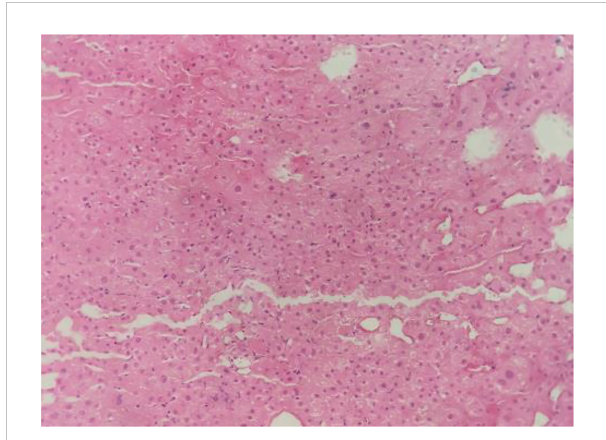
FIGURE 3 Histological fi ndings of the liver at autopsy (hematoxylin and eosin staining). The pathological diagnosis is hepatocellular